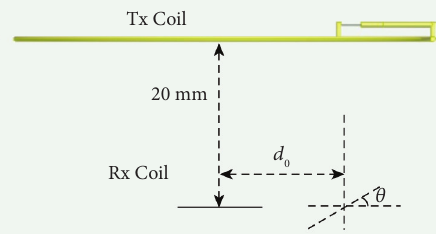
Figure 7: The WPToptimization model in HFSS when the implant has a horizontal offset ( d 0 ) and a vertical angle deviation ( θ ).